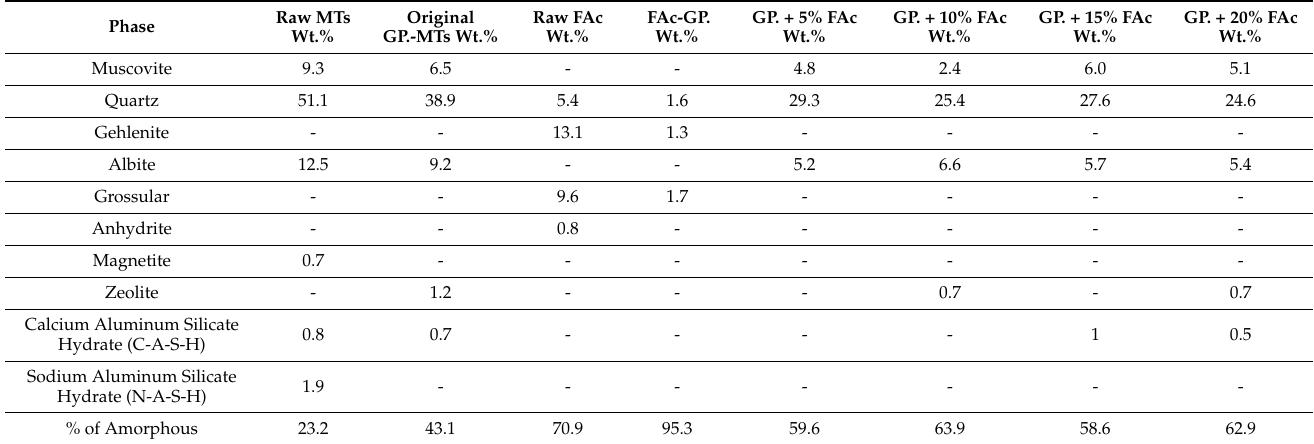
Table 2. QXRD analyses of the raw materials (MTs and FAc), their own geopolymers, and the co- geopolymers of the MTs with different FAc content. Only phases contributing ≥ 0.5 wt.% of the sample are